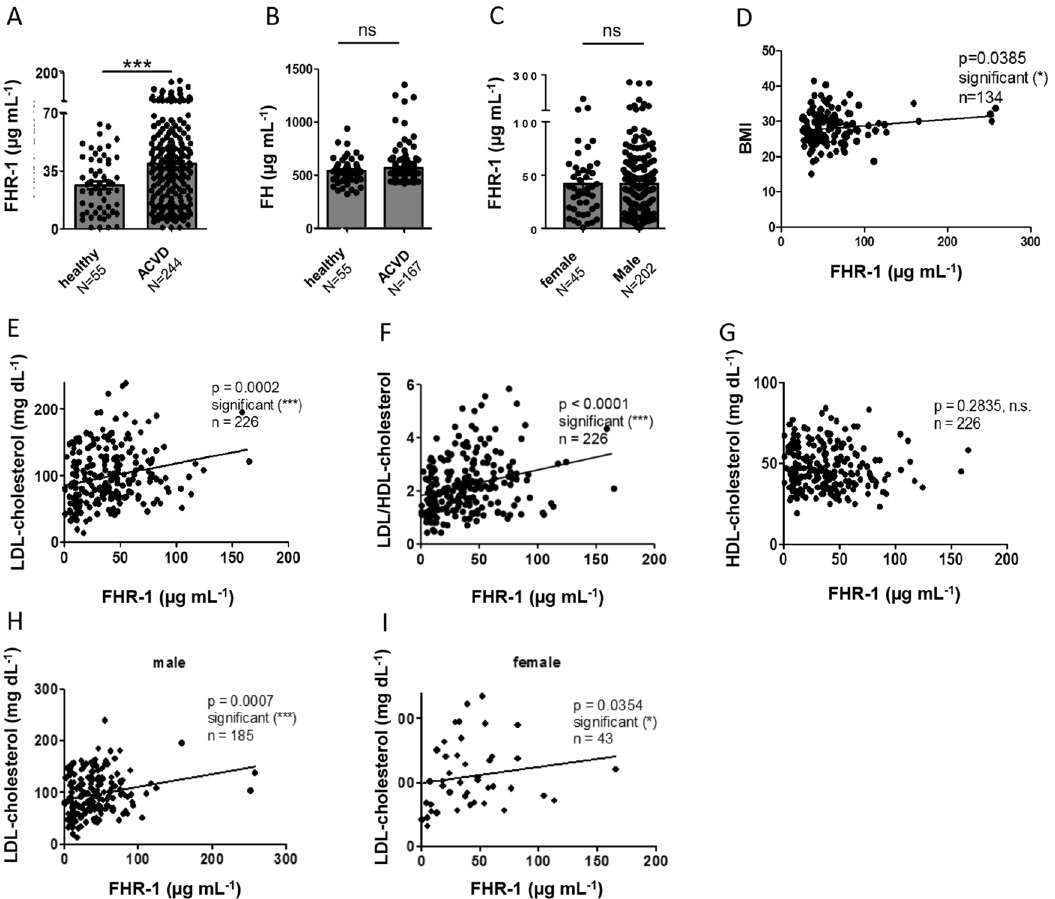
Figure 3. Elevated serum FHR-1 concentrations in ACVD patients correlate with low-density lipoprotein (LDL)-cholesterol concentrations. (A) FHR-1 concentrations were significantly higher in ACVD patients than in healthy individuals, (B) whereas Factor H concentrations were similar in the two groups. (C) Equal elevation of FHR-1 concentrations in men and women with ACVD. (D–G) Correlations of FHR-1 concentrations with (D) body mass index (BMI), (E) LDL concentrations, and (F) LDL/HDL ratios, but not (G) HDL concentrations, in patients with ACVD. (H,I) Correlations of FHR1 and LDL concentrations in (H) men and (I) women with ACVD. Data in (A–C) are reported as mean ± SEM and compared by unpaired two-tailed t-tests with Welch’s correction. Data in (D–I) represent Spearman’s correlations, *p ≤ 0.05, ***p ≤